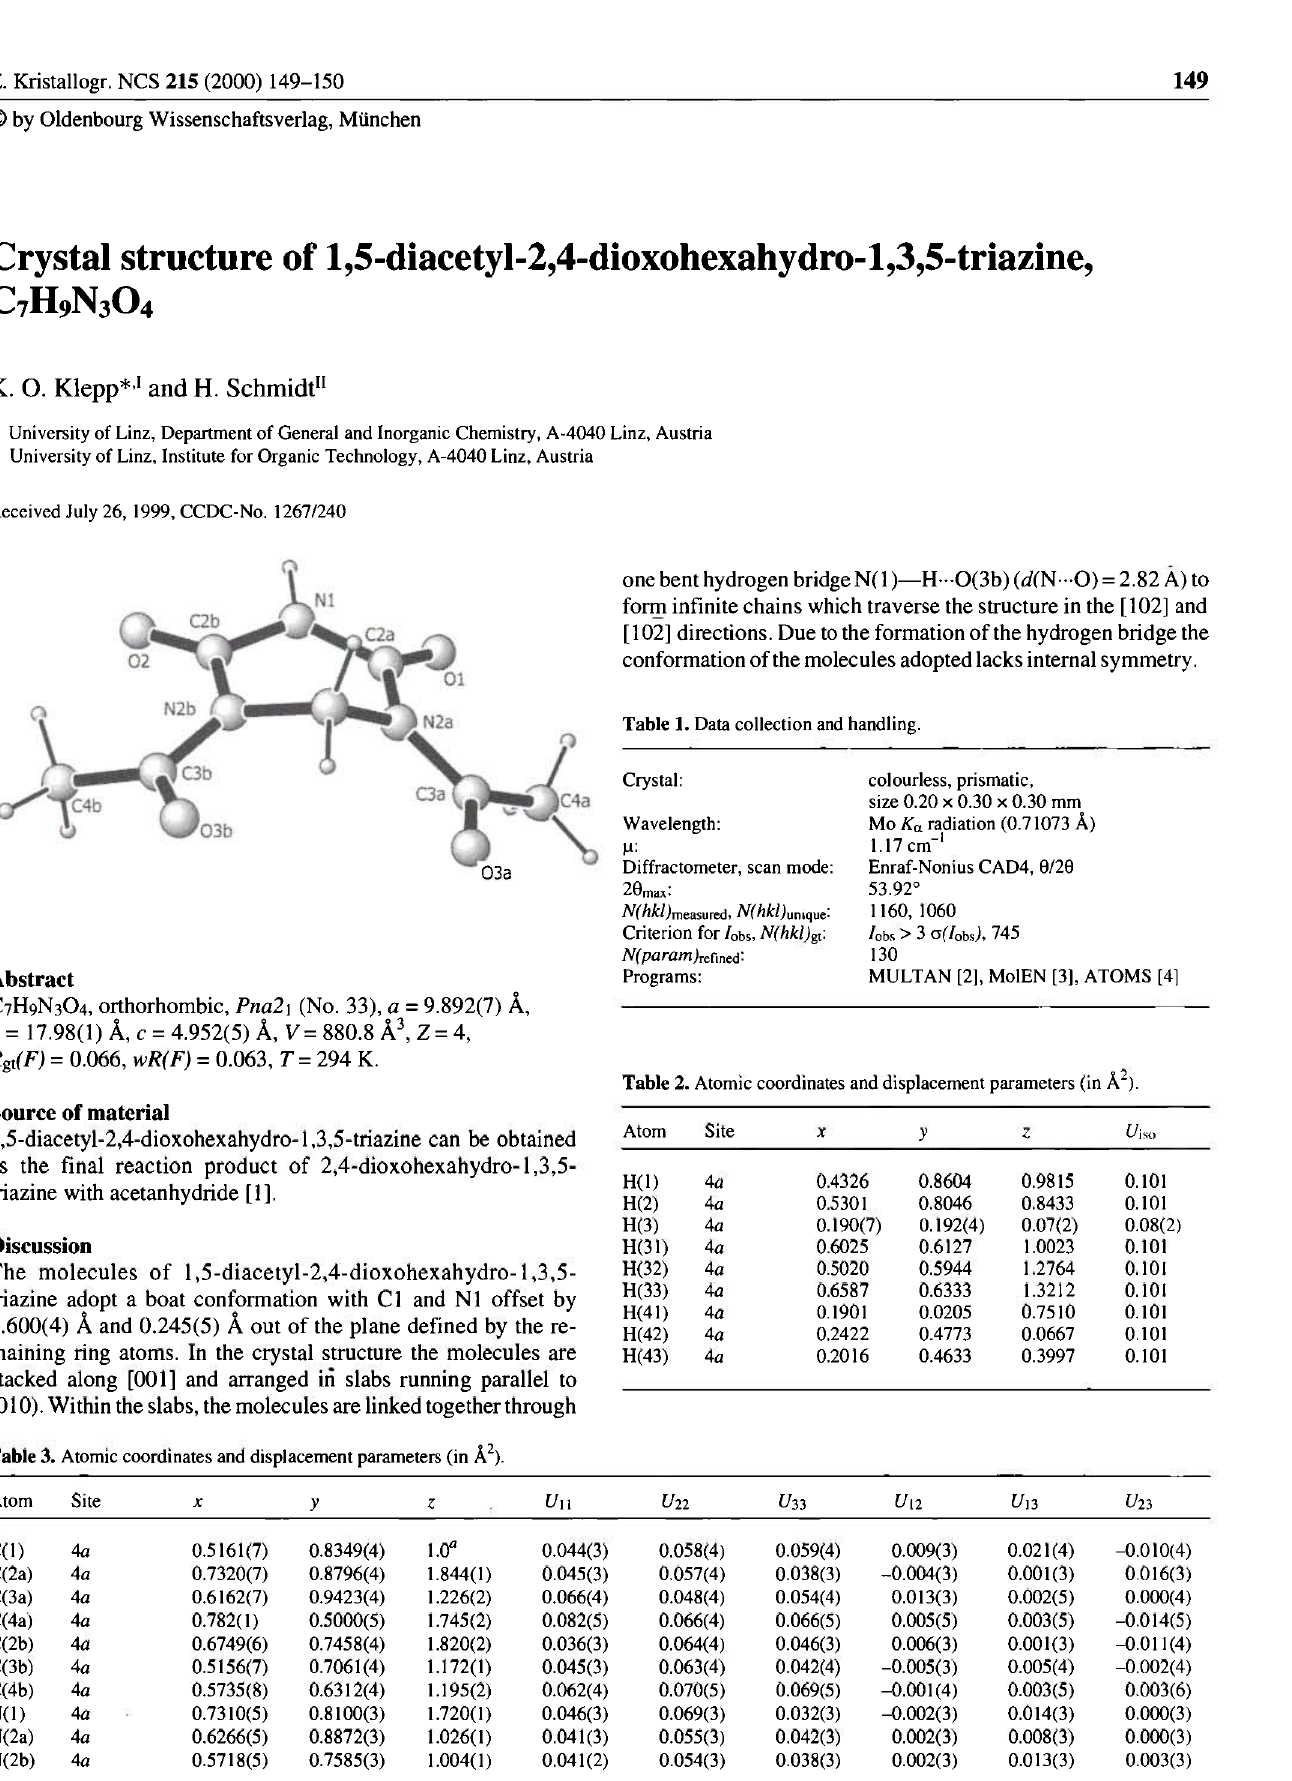
Table 2. Atomic coordinates and displacement parameters (in Ä 2